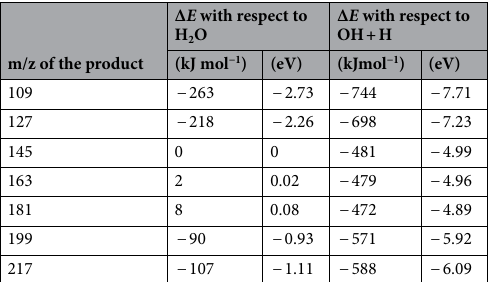
m/z of the product